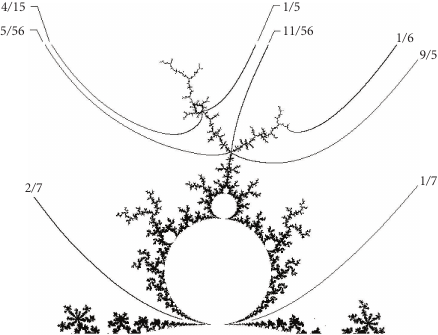
Figure 1.2 . Four notable points of the boundary of the Mandelbrot set. Two of them, one root point and one cusp point, have external arguments with odd denominator; and the other two, one branch point and one tip point, are Misiurewicz points that have external arguments with even